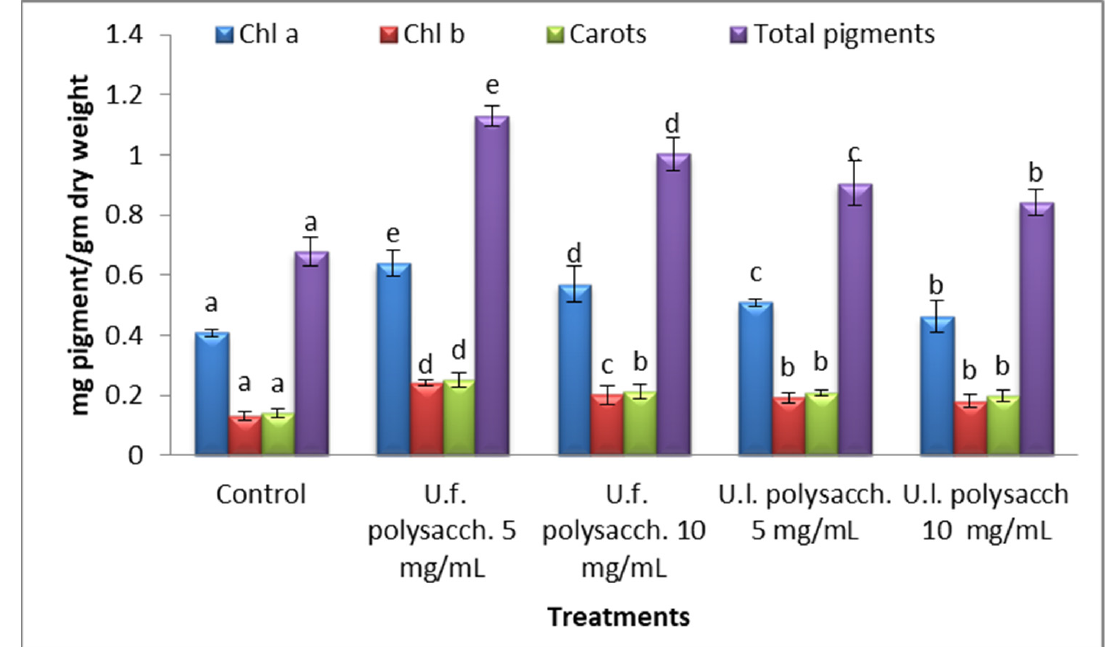
Figure 9. Effect of seed priming with different concentrations of soluble polysaccharides on the photosynthetic pigment contents of growing Zea mays seeds. The bars represent the standard error (different letters denote the significant values among treatments with the same pigments). U.f., Ulva fasciata; U.l., Ulva lactuca.